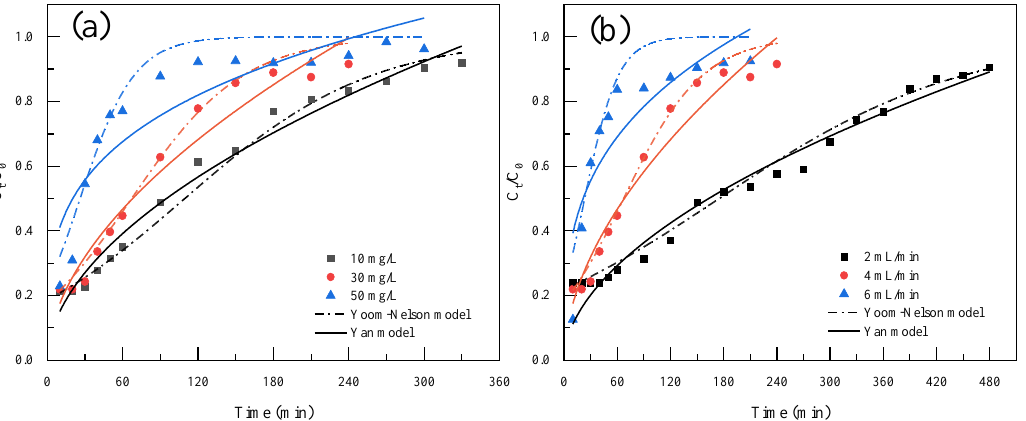
Figure 8. Effects of initial concentration ( a ) (Q 0 = 4 mg/L, m 0 = 0.6 g) and inflow rate ( b ) (C 0 = 30 mg/L, m 0 = 0.6 g) on breakthrough curves of CQP onto Fe/Mg-RSB. Data were simulated with the Yoom – Nelson model and Yan model.